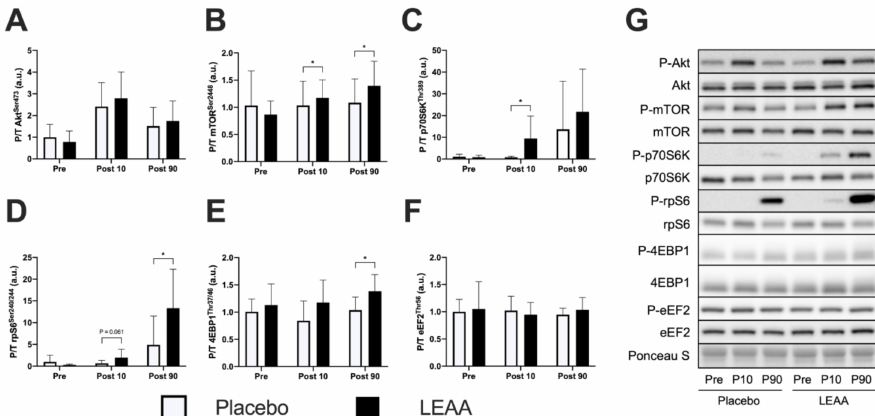
Figure 4. The phosphorylation of proteins in mTORC1 signaling. ( A ) Akt, ( B ) mTOR, ( C ) p70S6K, ( D ) rpS6, ( E ) 4EBP1, ( F ) eEF2 and ( G ) the representative bands. The data were analyzed using